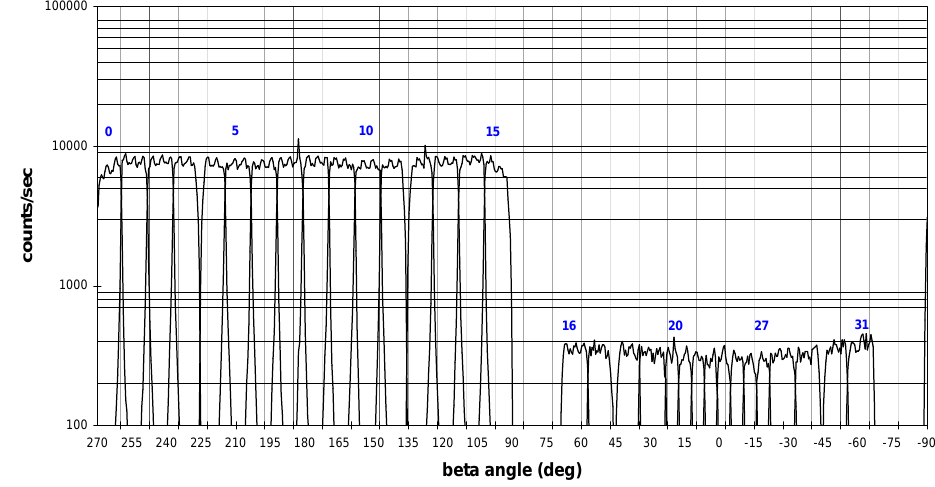
Fig. 5. Relative transmission of the 16 HIA High G (from 270 ◦ to 90 ◦ ) and 16 HIA Low g (from 90 ◦ to − 90 ◦ ) polar sectors (see Fig. 3) for FM6 at 5keV.